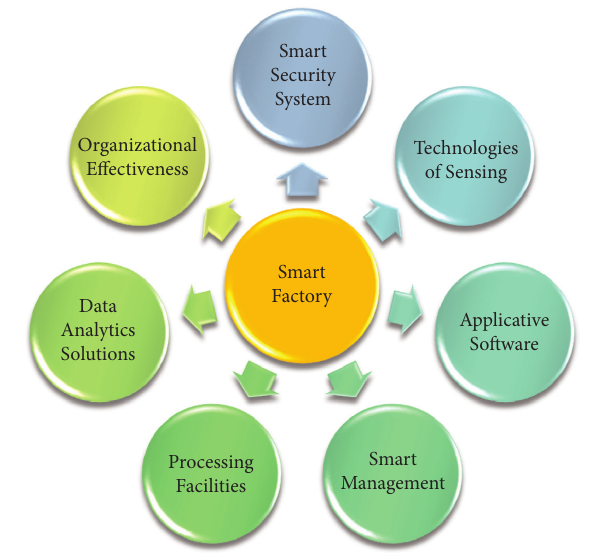
Figure 1: Components of the smart